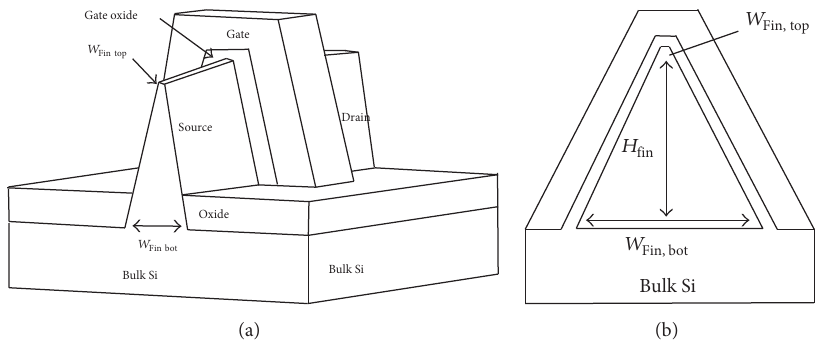
Figure 1: Triangular FinFET. (a) 3D schematic representation. (b) Triangular fin cross section of FinFET.